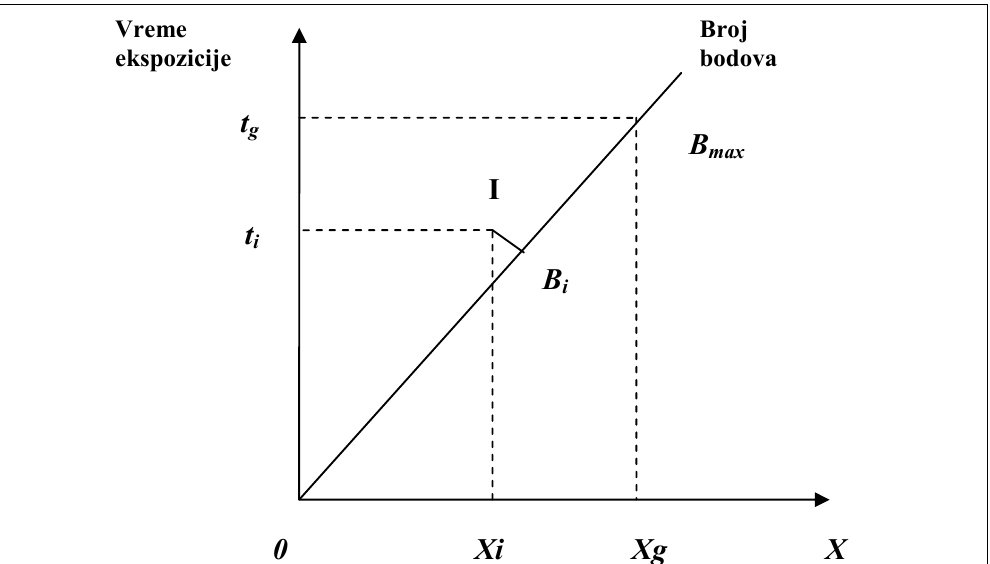
vremena ekspozicije gde je: 0 – po č etno vreme i po č etna vrednost posmatranog faktora; X